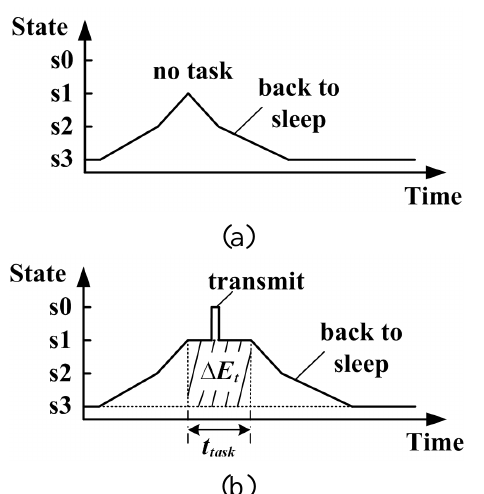
Figure 2. Power curves of sensor node (a) which is not selected to implement task and (b) which is selected to implement